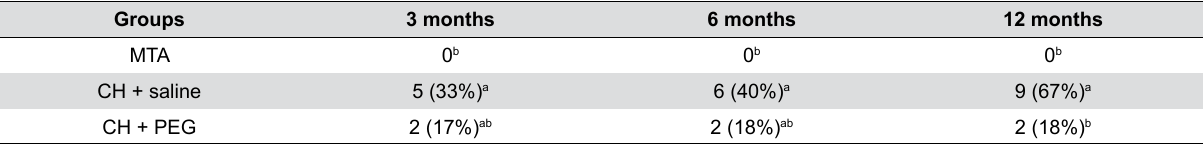
Table 2- Internal resorption radiographically observed for MTA, CH+saline and CH+PEG pulpotomies at 3-, 6-, and 12-month follow-up